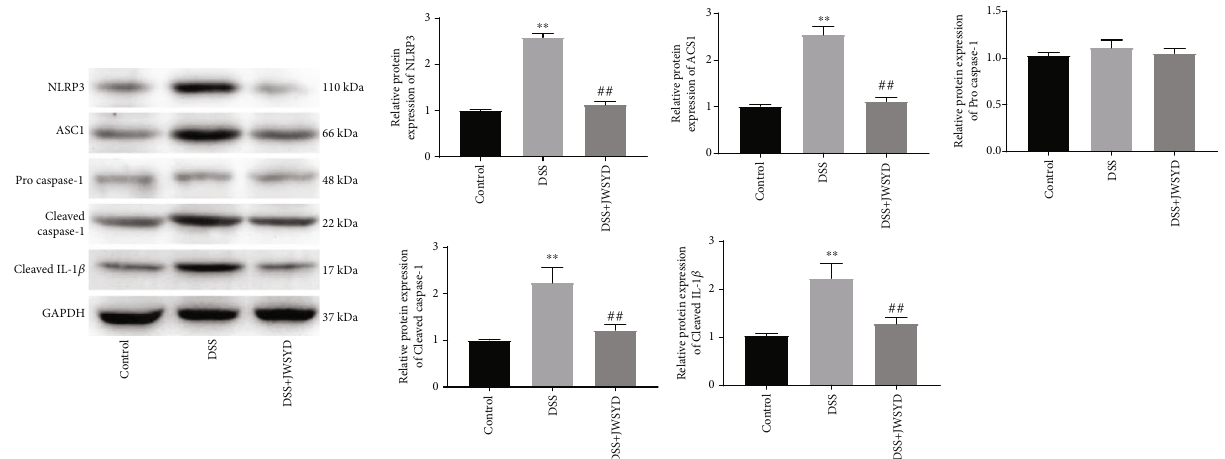
Figure 3: Jiaweishaoyao decoction (JWSYD) inhibited the NLRP3 in fl ammasome in DSS-induced ulcerative colitis (UC). The protein levels of NLRP3 in fl ammasome-associated proteins (NLRP3, ASC1, Procaspase-1, Cleaved caspase-1, and Cleaved IL-1 β ) were detected by western blot. ∗∗ P < 0 : 01 compared with the control group; ## P < 0 : 01 compared with the DSS